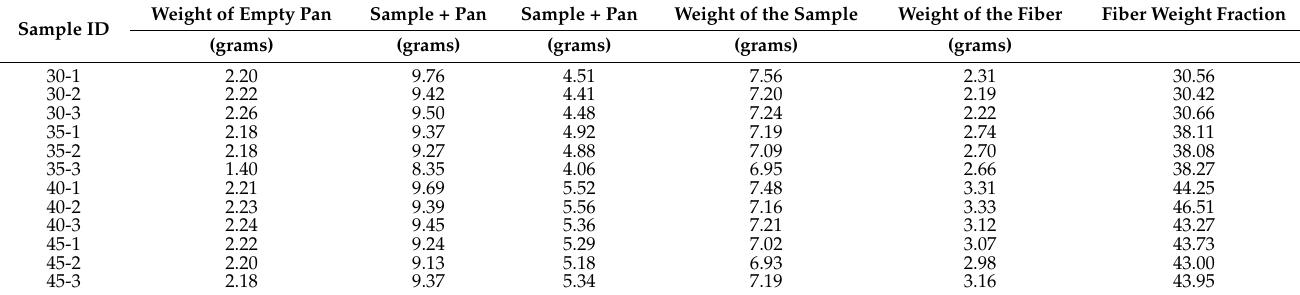
Figure 3. SEM of ‘as received’ manufacturing scrap material showing limited resin wet-out on glass fibers. This indicates the as-received material had very high fiber content, >70 wt%.